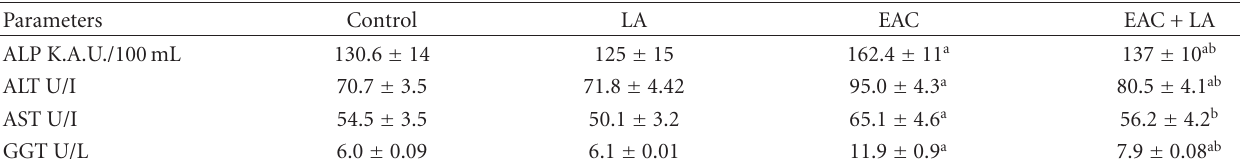
Table 6: Activities of ALP (alkaline phosphatase), ALT (alanine aminotransferase), AST (aspartate aminotransferase) and GGT (gamma glutamyl transferase) in serum of di ff erent animal groups.